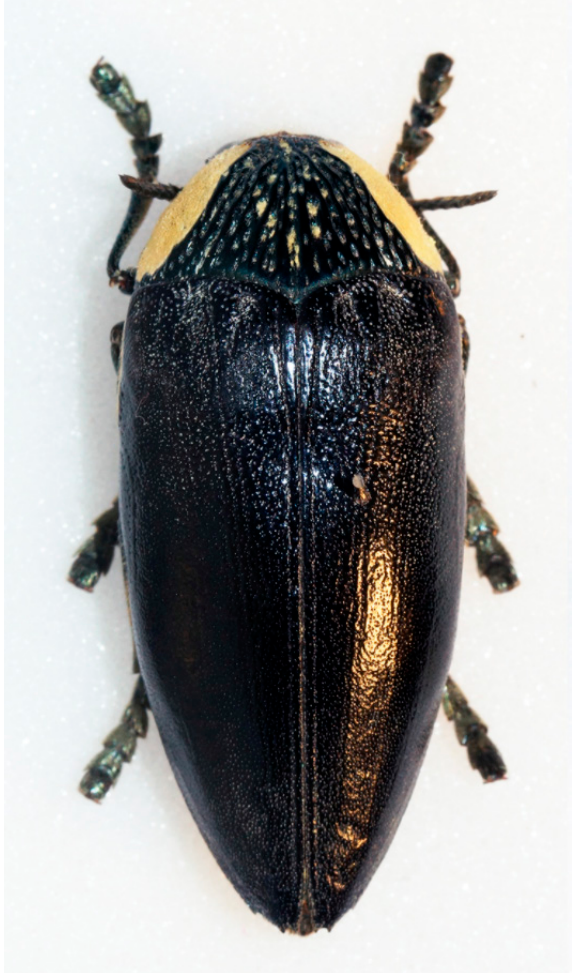
Figure 2. The jewel beetle Sternocera orissa (Buprestidae) is eaten in southern Africa. https: //commons.wikimedia.org/wiki/File:Sternocera_orissa_monacha_-_Flickr_-_Bennyboymothman. jpg (Accessed on 20 April 2021). Attribution: Ben Sale from UK, CC BY 2.0, via Wikimedia